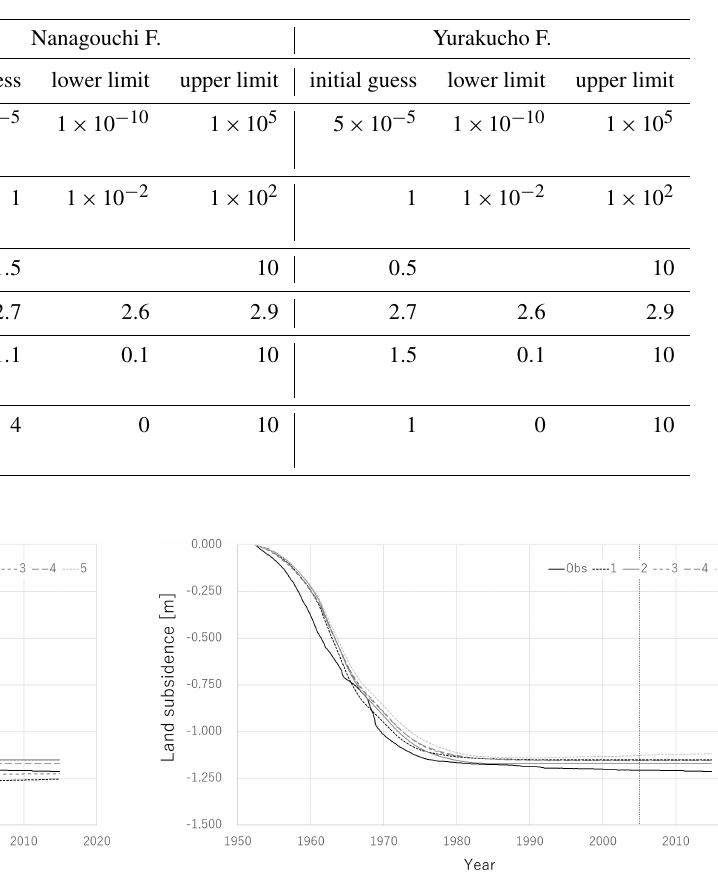
Figure 4. The variety of land subsidence prediction after the cali- bration in December 1984.